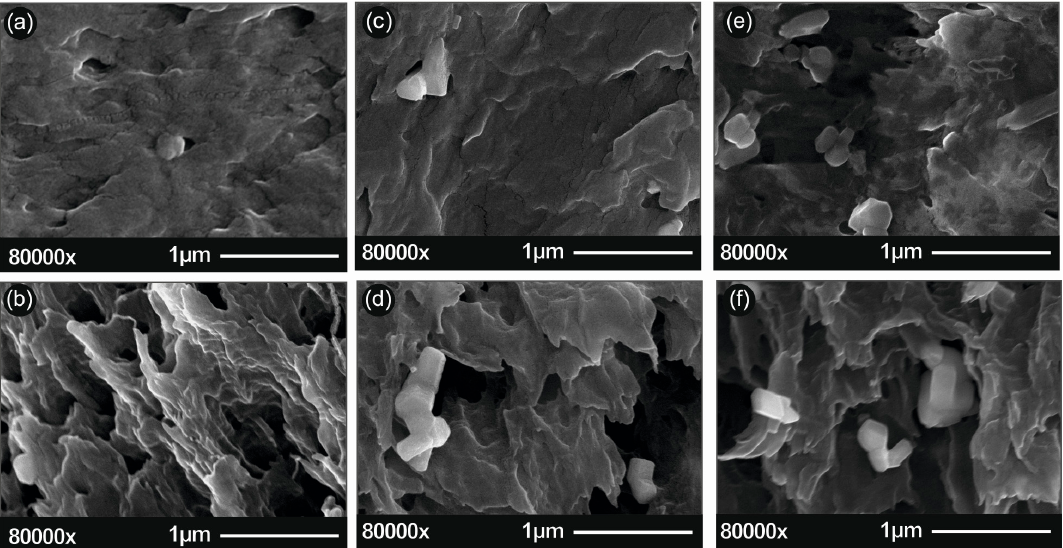
Figure 4. ( a ) SEM images of pure ABS surface area; ( b ) pure ABS section area; ( c ) ABS/ZnO micro